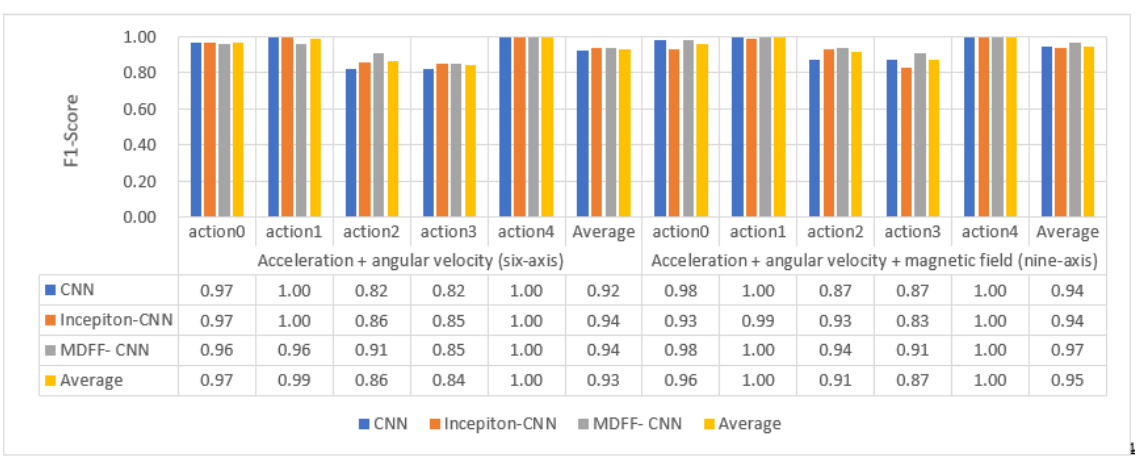
Figure 15. Recognition accuracy rate of convolutional neural network model on professional test set.